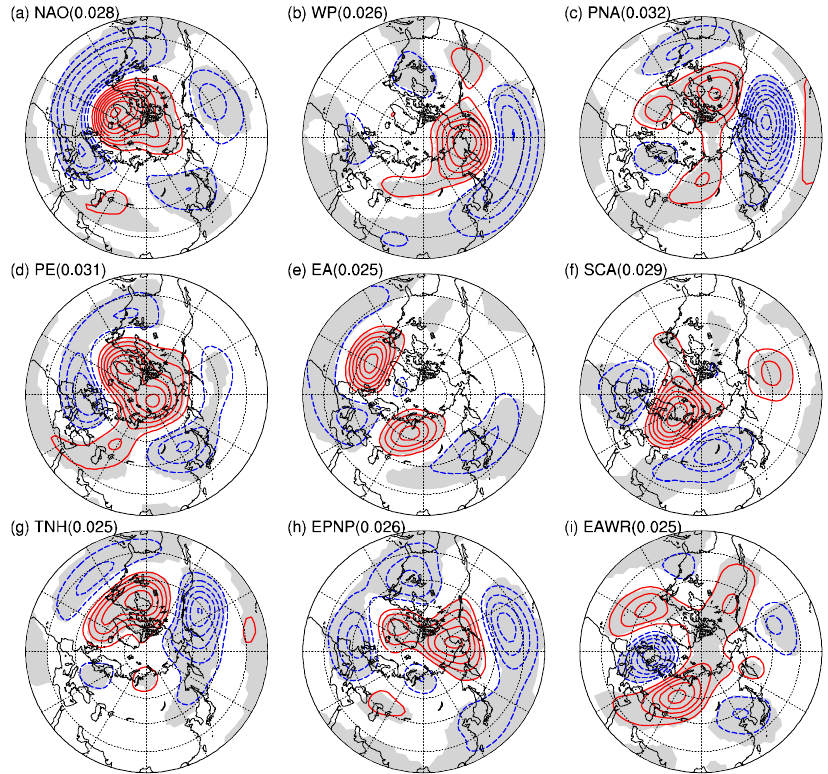
Figure 1. ( a – i ) Spatial patterns of the nine teleconnection patterns represented by linear regression coefficients of monthly 500 hPa geopotential height (Z500) anomalies on the normalized rotated principal component analysis (RPCA) time series during the 40 winters from 1979 to 2018, based on the ensemble mean of the three reanalysis datasets. Name of each teleconnection pattern is indicated in top left of the corresponding panel. Shading denotes significant anomalies based on two-tailed Student’s t test controlled by false discovery rates with 𝛼 (cid:2890)(cid:2888)(cid:2902)∗ = 0.05. Threshold values for the significance level, 𝑝 (cid:2890)(cid:2888)(cid:2902)∗ , are shown in the top left of each panel. Contours are drawn for ±50, ±100, …, m. Solid red and dashed blue lines represent positive and negative anomalies, respectively.